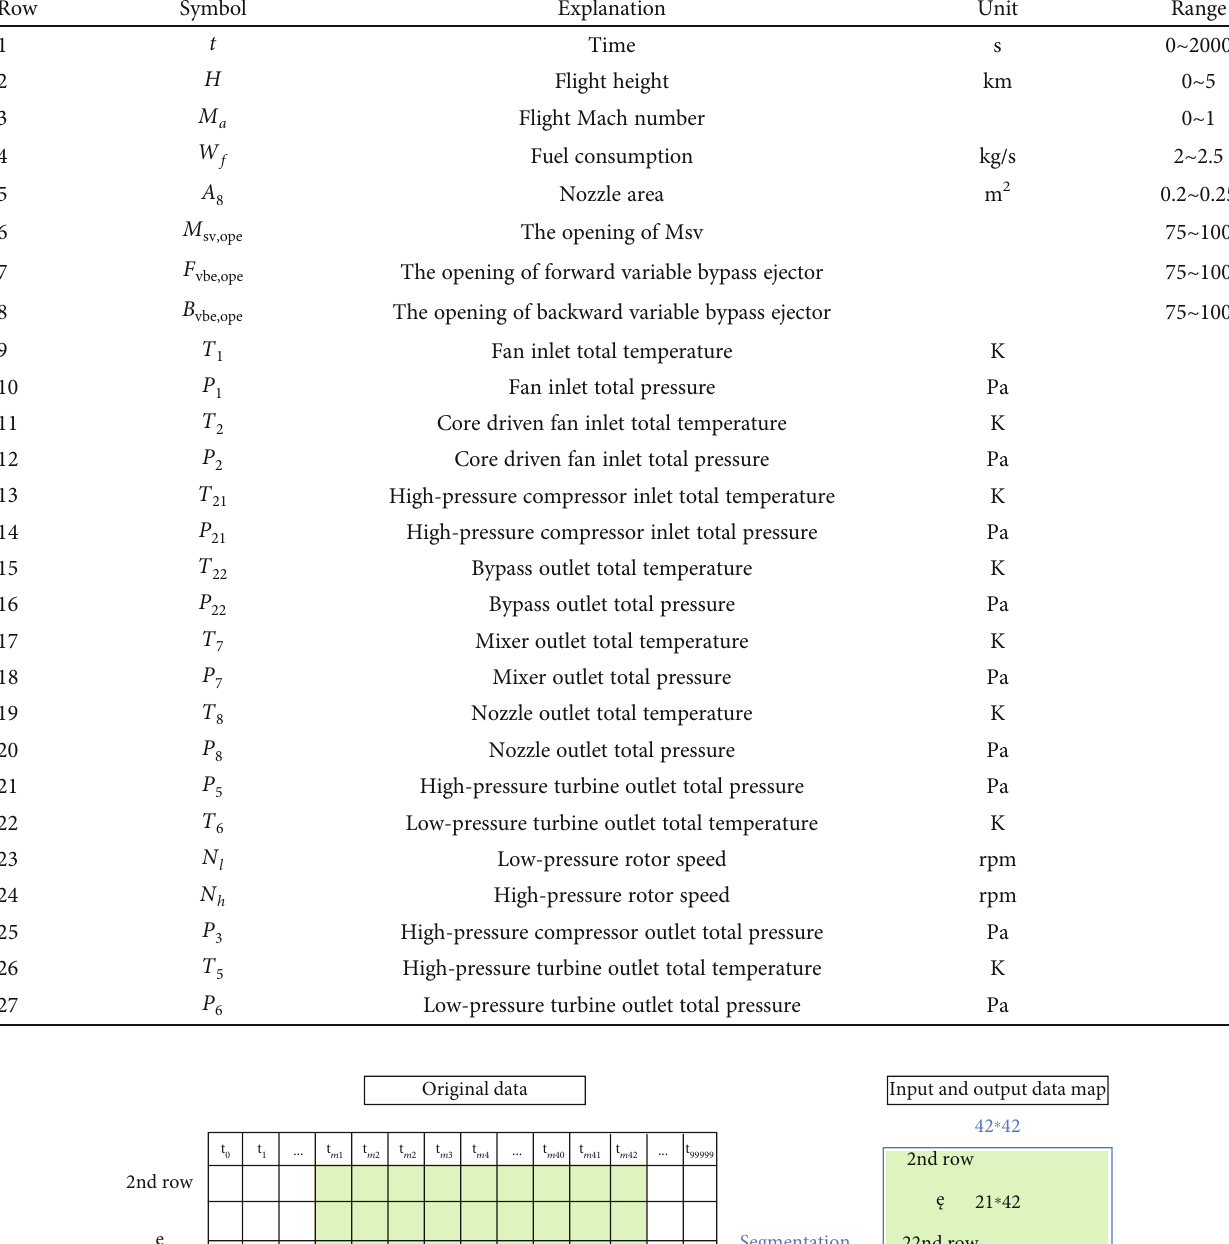
Table 1: Explanation of variables in original data set.